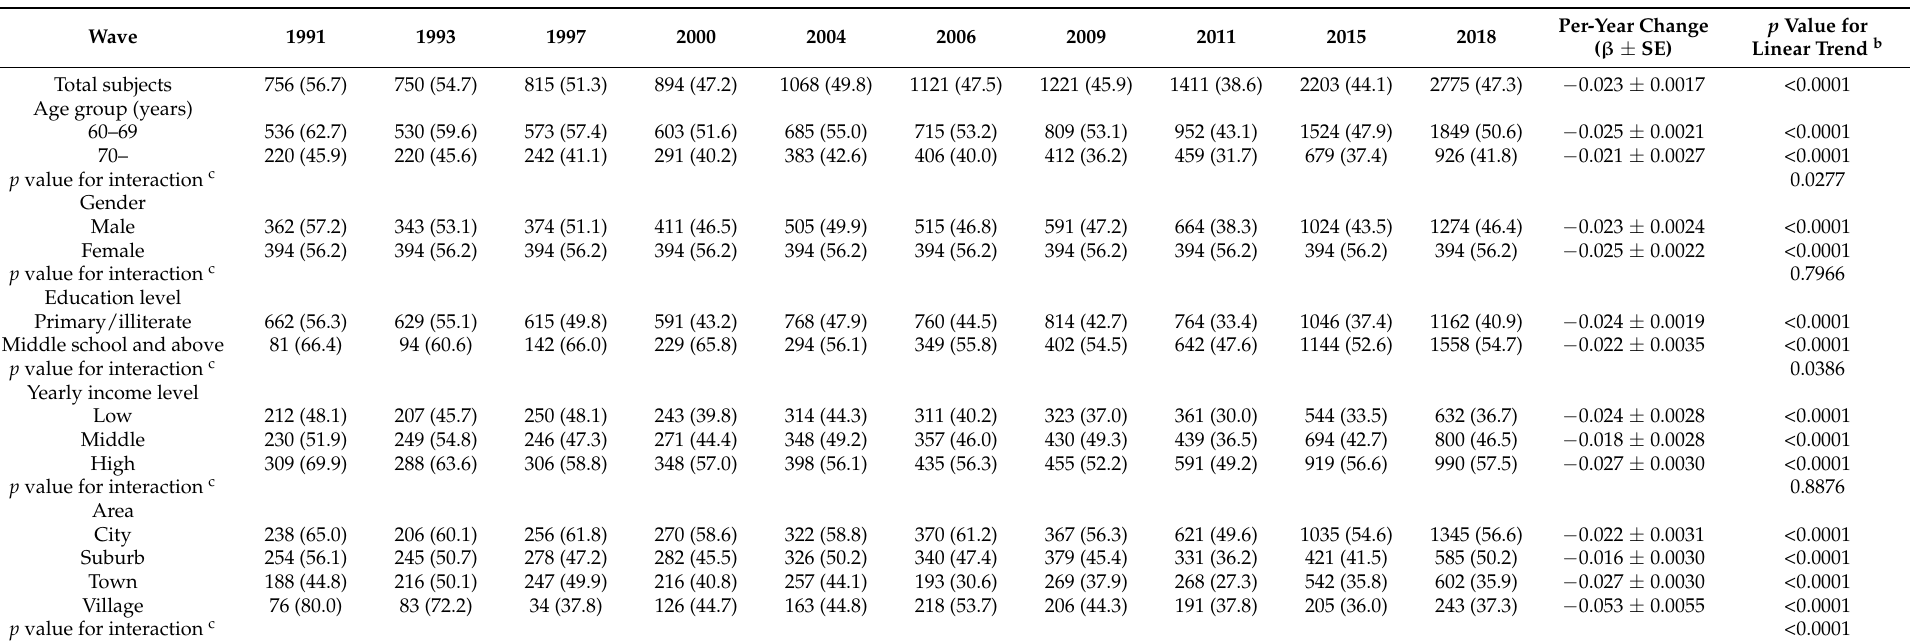
Table 4. Trends in proportion of daily protein intake above RNI among the elderly Chinese, 1991 to 2018 a